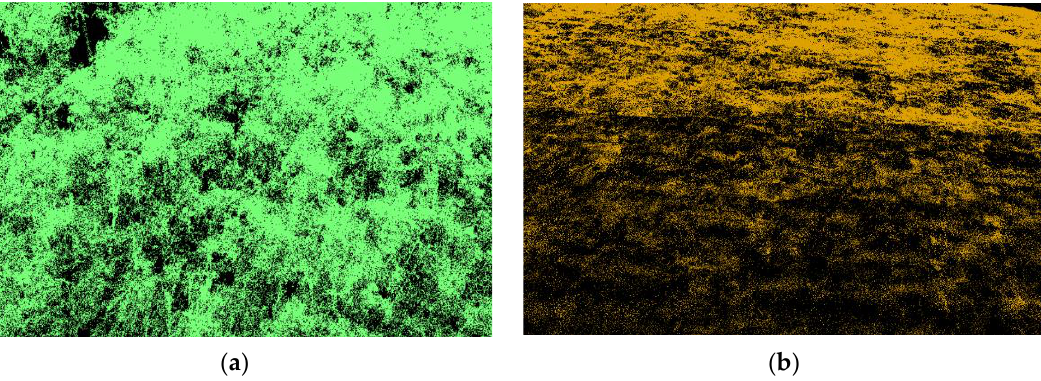
Figure 5. ( a ) Results of separating ground points; ( b ) results of separating non-ground